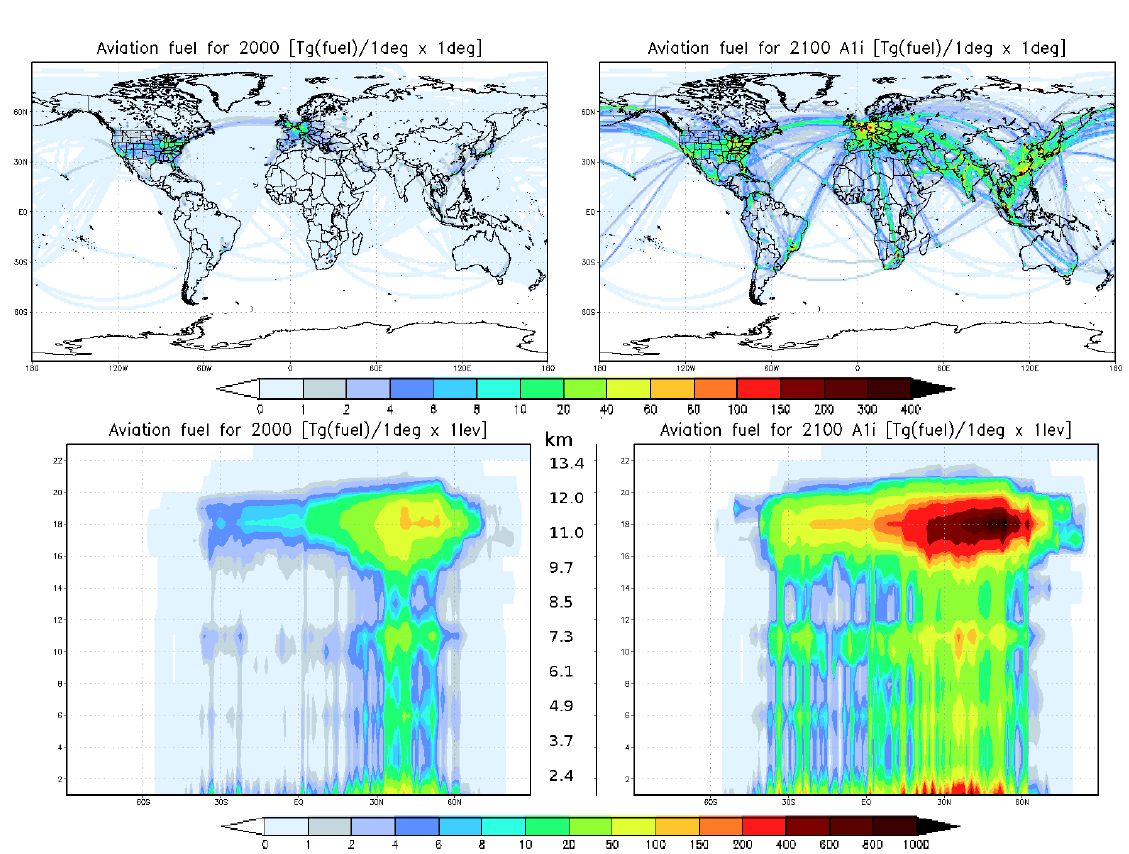
Fig. 1. Vertically (upper row) and zonally (bottom row) integrated aviation fuel consumption (Tg(fuel)yr − 1 ) for the years 2000 (left) and 2100 (right), assuming the A1(i) scenario (Lee et al.,